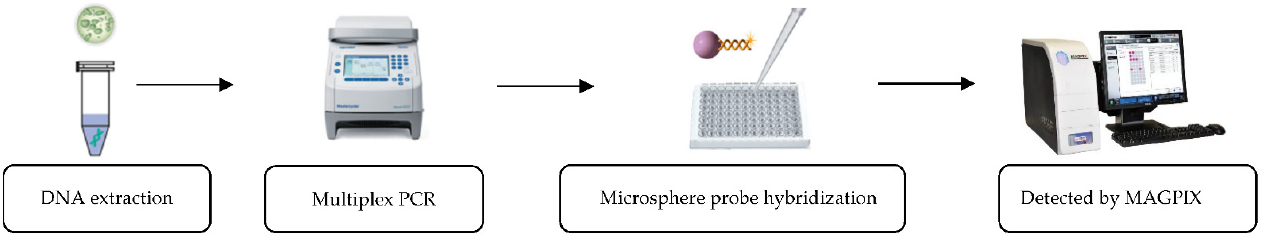
Figure 1. xMAP TIER test workflow. Table 1. Specific mutations designed for detection in the xMAP TIER assay.